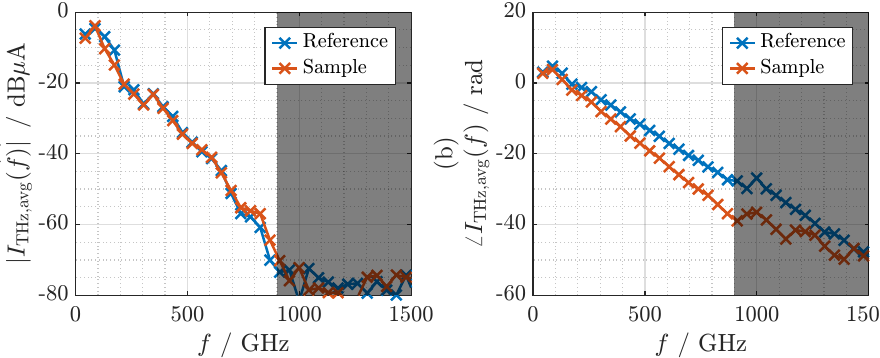
Figure 8. ( a ) Magnitude and ( b ) phase of the Fourier transform of the photocurrents from the terahertz receiver. Blue: without the sample. Red: with the COC